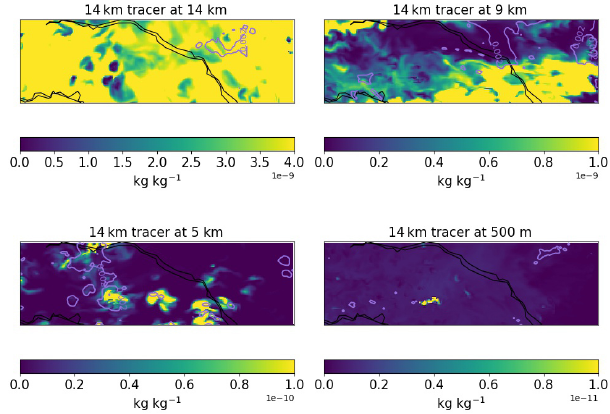
Figure 12. Regional domain-averaged profiles of passive tracer mass mixing ratios emitted from nine different model levels with vertical thicknesses ranging from 16m at the surface to 2000m at 16km (blue and black) in altitude.